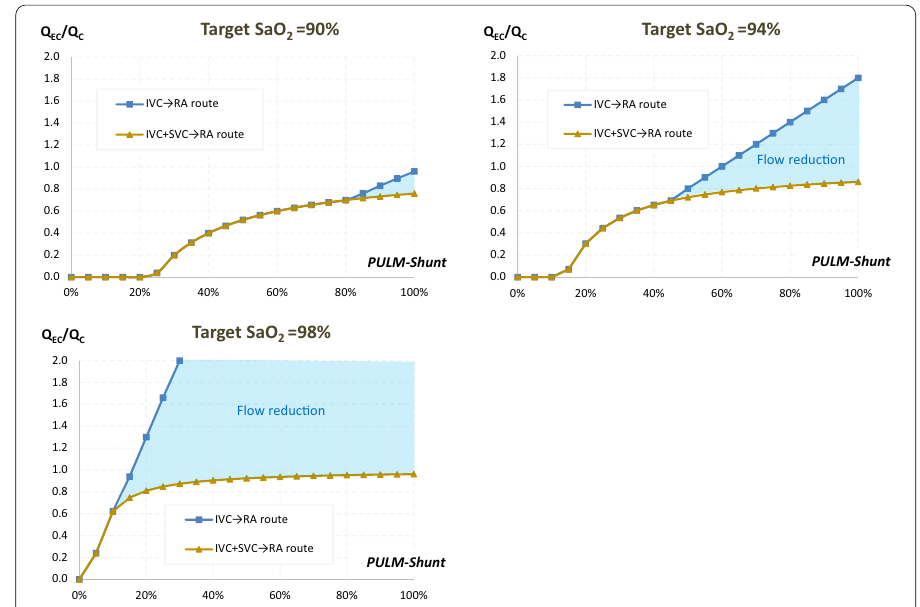
Fig. 4 Required Q EC to reach target SaO 2 . IVC inferior vena cava, PULM-Shunt pulmonary shunt, Q EC extracorporeal pump flow, Q C cardiac output, RA right atrium, SaO 2 arterial blood oxygen saturation, SVC superior vena